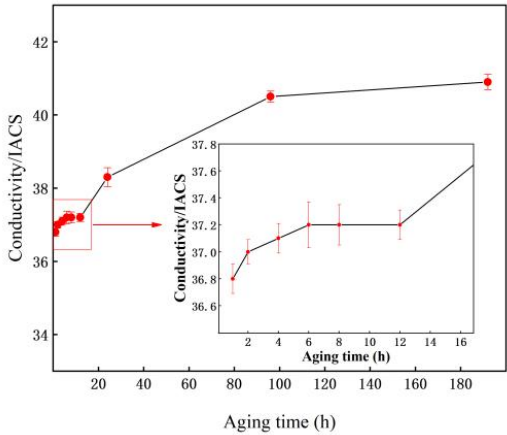
Figure 6. Electrical conductivity curves of 7005 aluminum alloy plates aged at 120 °C for different durations.